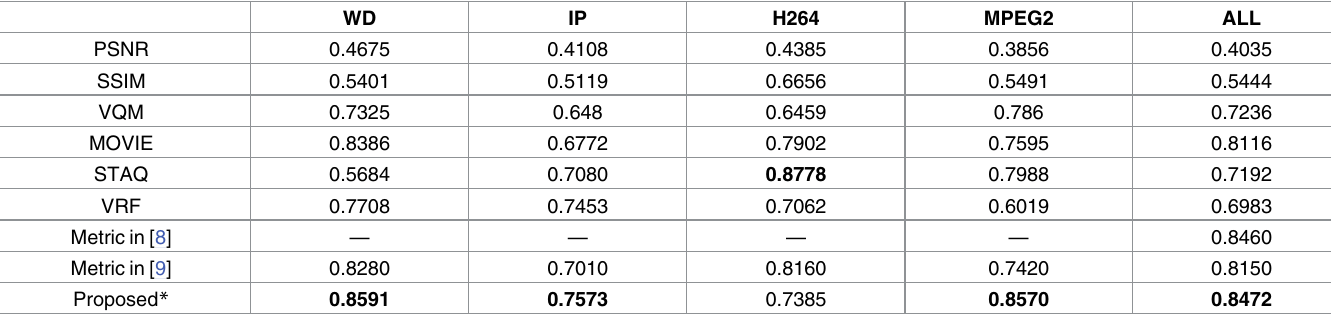
Table 4. Performancecomparison on the LIVE VQA